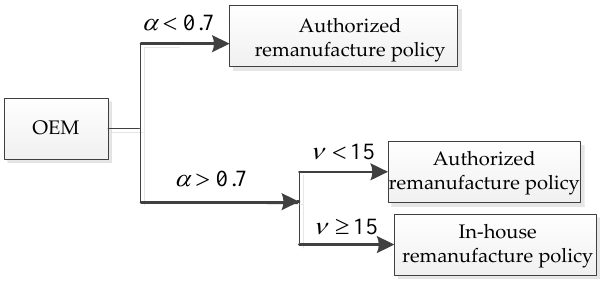
Figure 11. The effect of carbon trading system on OEMs’ remanufacturing strategies.